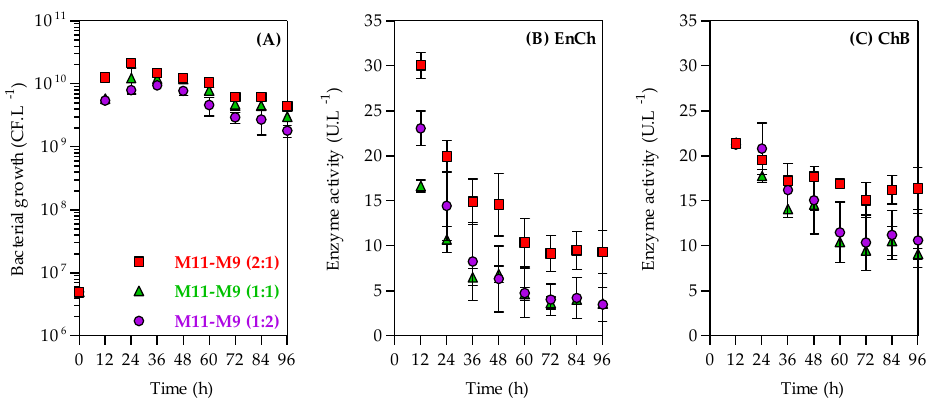
Figure 4. Endochitinase (EnCh) ( A ) and chitobiosidase (ChB) ( B ) activity at 12 h Aeromonas caviae CHZ306 is cultivated in the chitin-containing medium under different nitrogen supplementations (viz. M1–M12). M1 (ammonium sulfate), M2 (ammonium acetate), M3 (ammonium nitrate), M4 (urea), M5 (casaminoacids), M6 (meat extract), M7 (yeast extract), M8 (peptone Bacto), M9 (peptone A), M10 (peptone G), M11 (corn-steep solids), and M12 (tryptone). All data represent the mean ± standard deviation (sd). Different letters indicate statistical differences among columns for each enzyme ( p < 0.05).